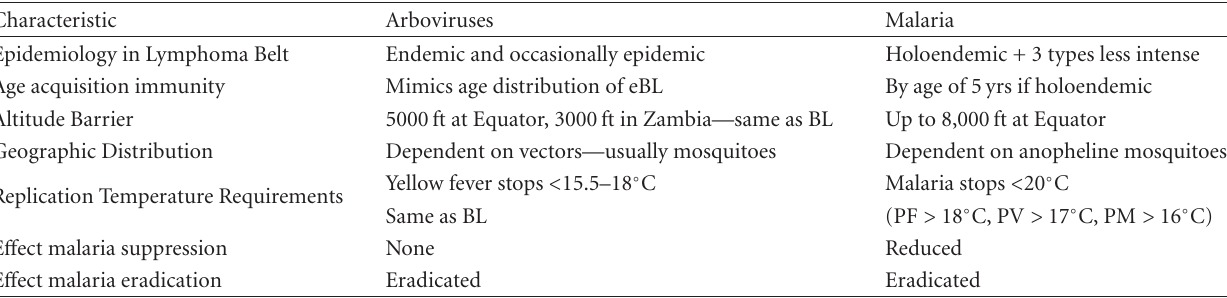
Table 2: Arboviruses and Malaria—a comparison.